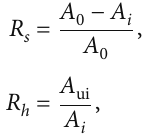
Figure 1: Schematic diagram of the experimental